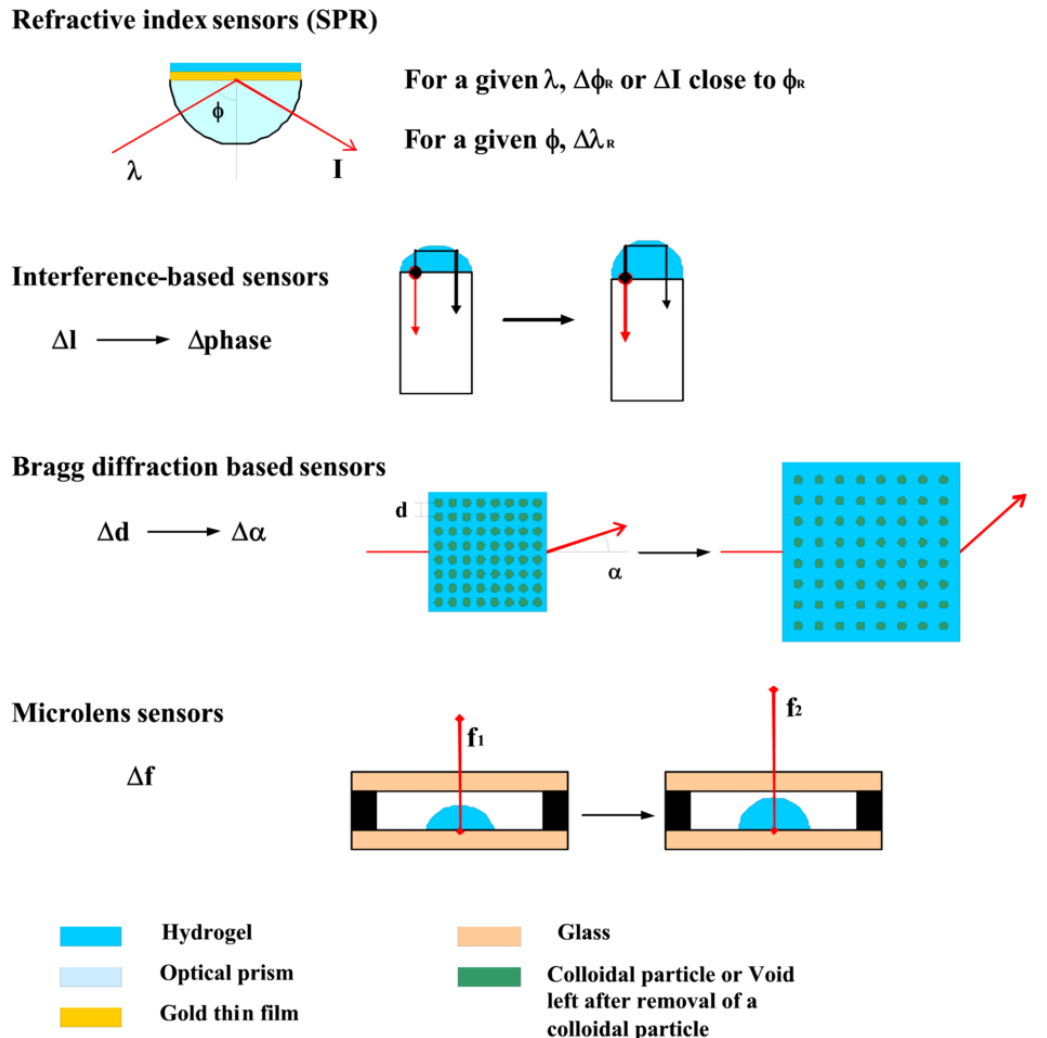
Figure 6. Schematics of the principal optical transduction schemes.  : wavelength,  R : resonance wavelength, I: intensity,  R : resonance angle, l: optical path, d: lattice spacing,  : diffraction angle, f: focal